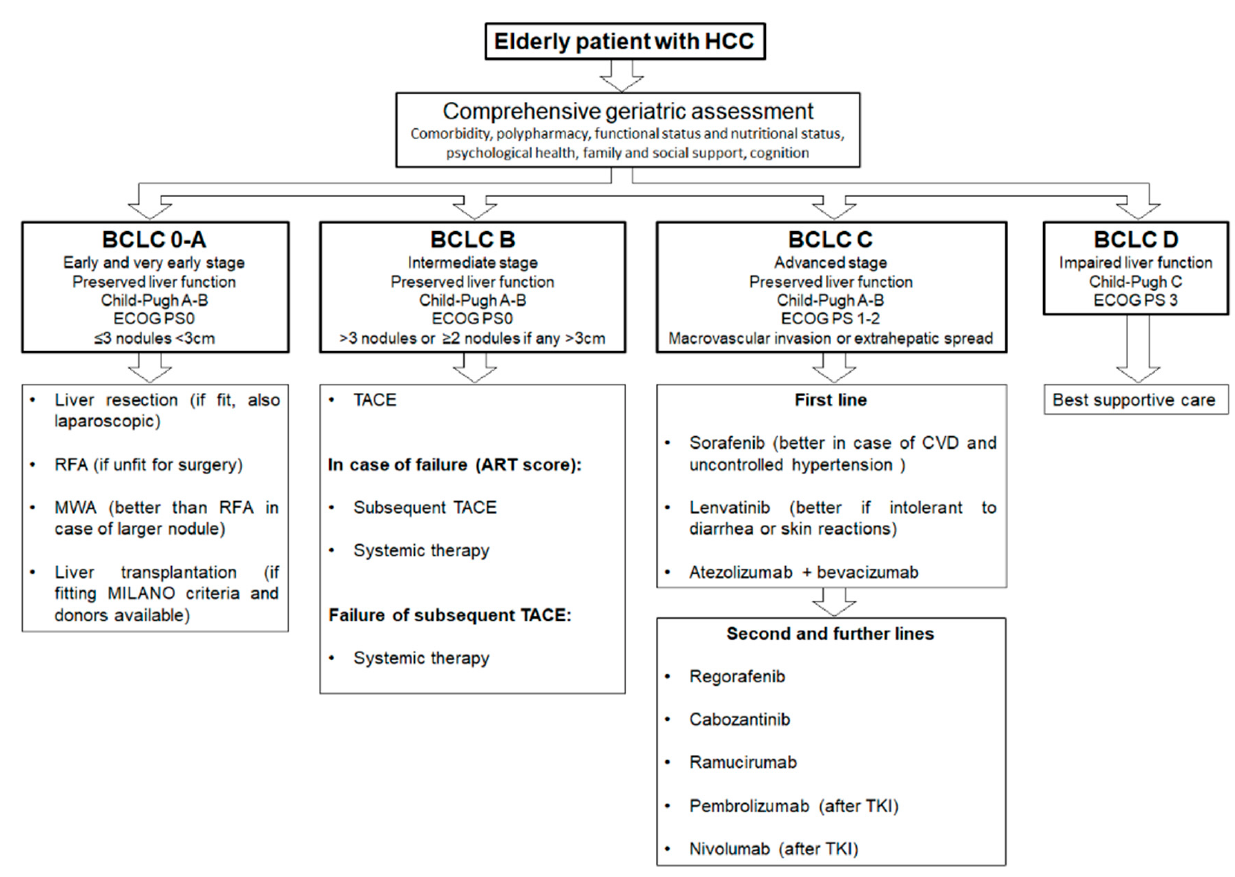
Figure 2. Proposed algorithm for treating elderly hepatocellular carcinoma (HCC) patients according to Barcelona Clinic Liver Cancer (BCLC) stages.